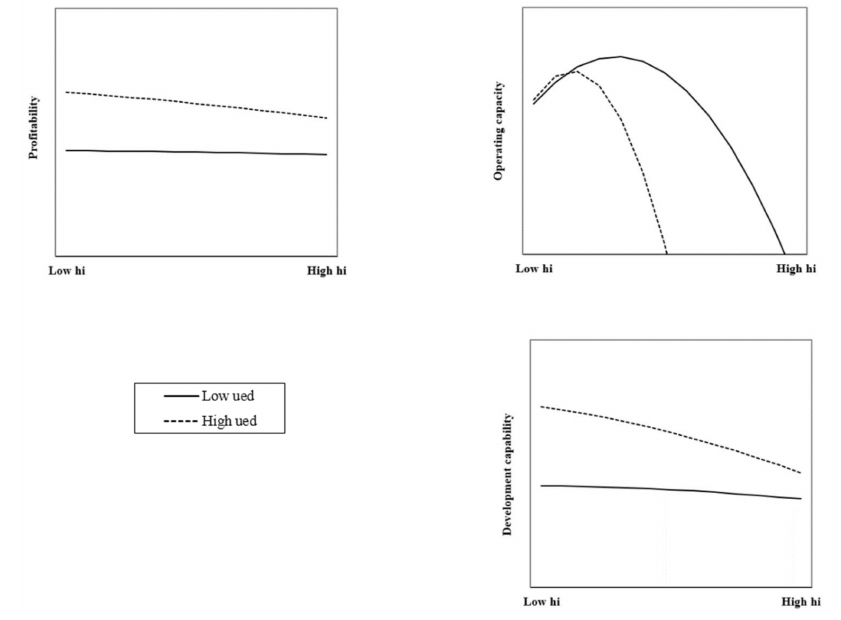
Figure 4. Regulatory effect of port cities’ UED